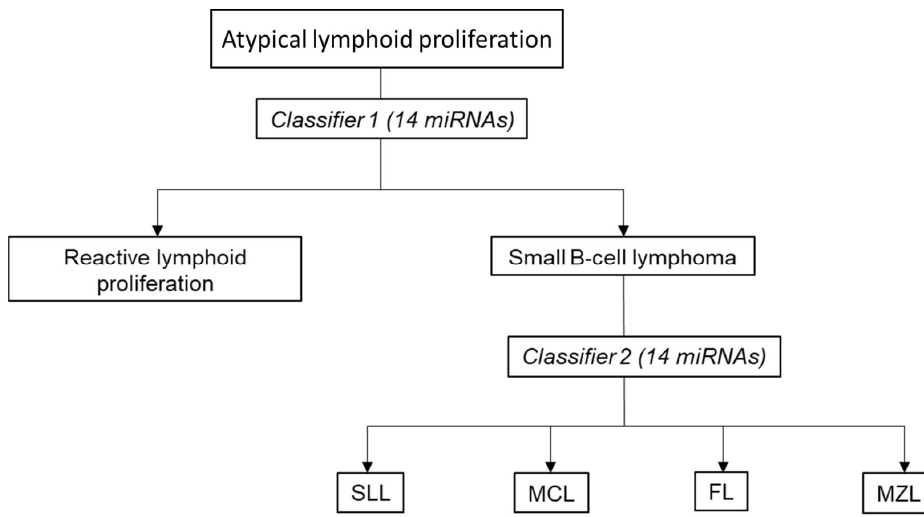
Figure 6. A proposed diagnostic algorithm incorporating miRNA-based classifiers for the workup of lymphoid proliferation morphologically suspicious of small B-cell lymphoma. Abbreviations: miRNA, microRNA; SLL, small lymphocytic lymphoma/chronic lymphocytic leukemia; CLL, chronic lymphocytic leukemia; FL, low-grade follicular lymphoma; MCL, mantle cell lymphoma; MZL, marginal zone lymphoma.